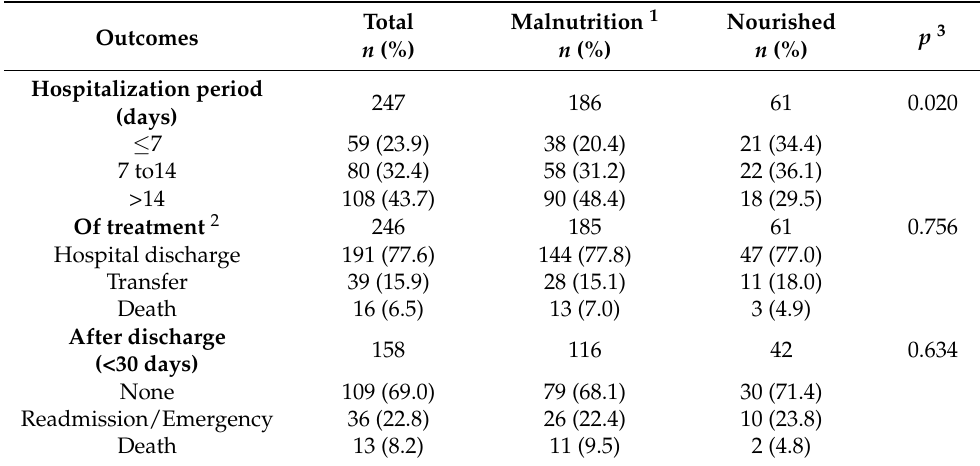
Table 4. Comparison of in-hospital and post-discharge ( ≤ 30 days) clinical outcomes of the sample, according to the nutritional status of hospitalized patients with heart failure, in the public and private health systems in Brazil, from April 2018 to January 2021. Outcomes